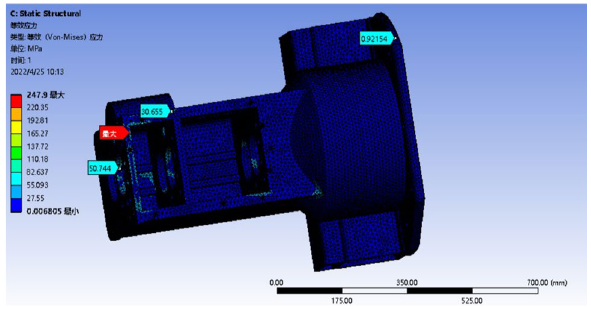
Figure 18. Four stress nephogram.